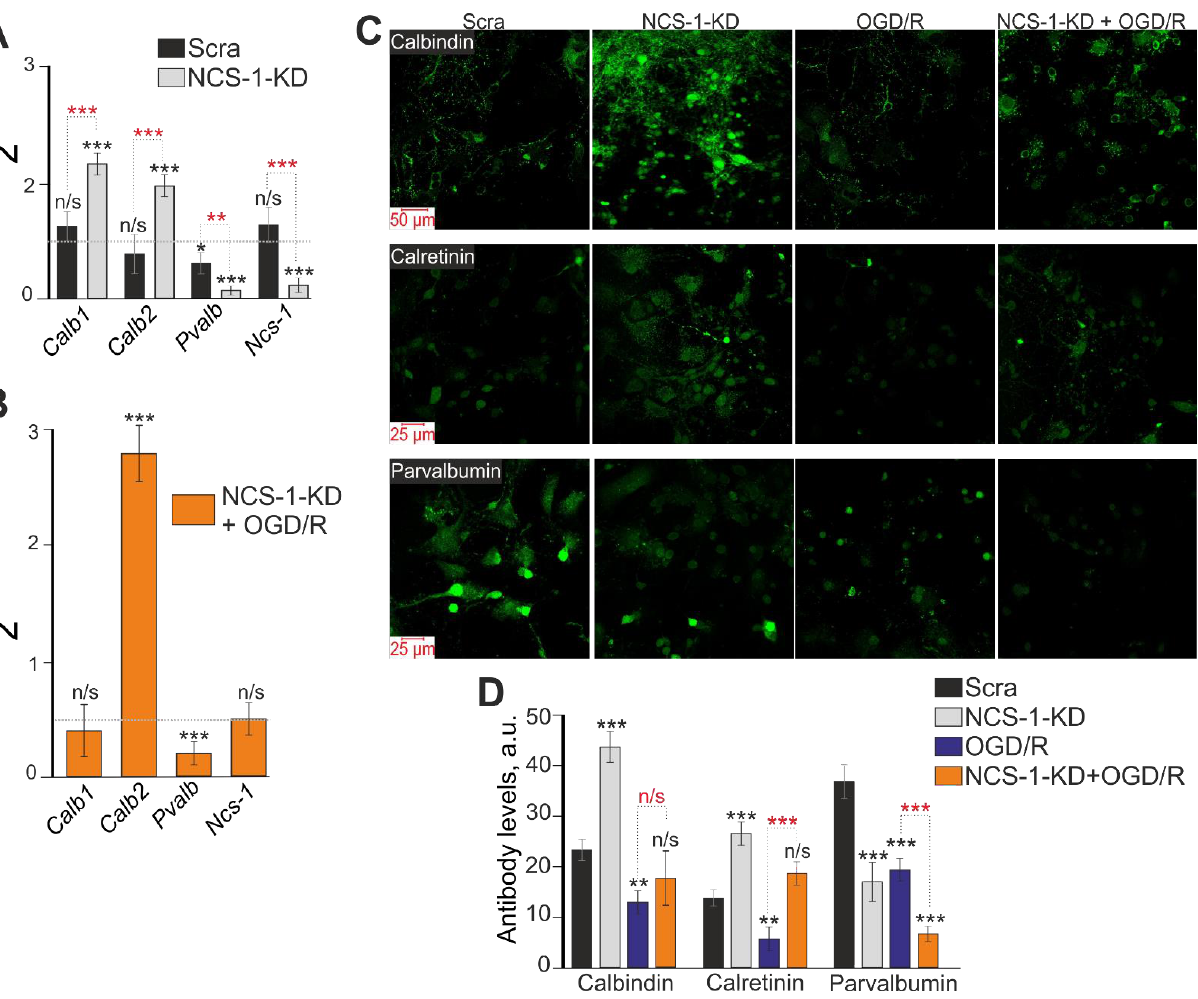
Figure 6. Effect of NCS-1-KD on basal and OGD/R-induced expression of calcium-binding proteins calbindin (Calb1), calretinin (Calb2), and parvalbumin (Pvalb). ( A ) Basic expression of genes encoding calcium-binding proteins in the Scra experimental group (siRNA, which sequence differed from the sequence of siRNA against NCS-1) and NCS-1-KDcells (NCS-1-KD). Dashed line level of gene expression in control. Statistical significance was assessed using paired t -test compared to Control cells (marked with black asterisks). Comparison between experimental group Scra and experimental group NCS-1KD is marked by red asterisks. n/s — data not significant ( p > 0.05), * p < 0.05, ** p < 0.01, and *** p < 0.001. ( B ) Effect of NCS-1-KD on OGD/R-induced expression of genes